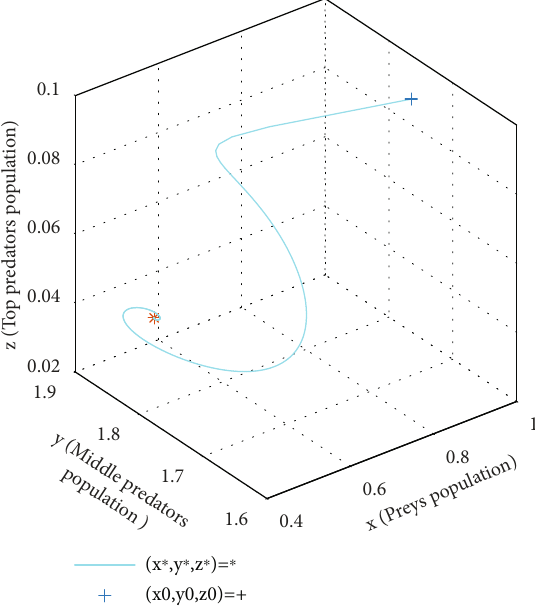
Figure 3: The plot shows the local stability of E